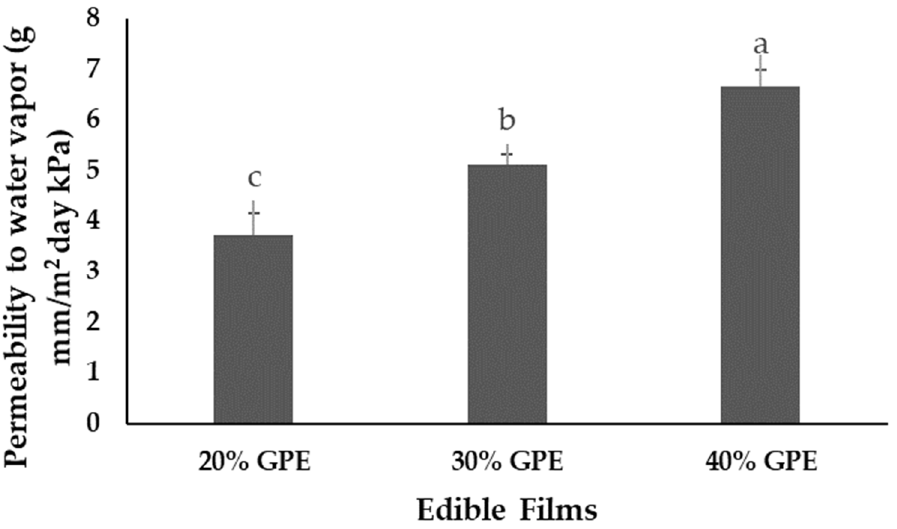
Figure 4. Water vapor permeability of edible films of arrowroot ( Maranta arundinacea Linn.) starch with 0, 20, 30, and 40% of grape pomace extract (GPE). Values with the same letter in the columns do not statistically differ by Tukey’s test ( p < 0.05).